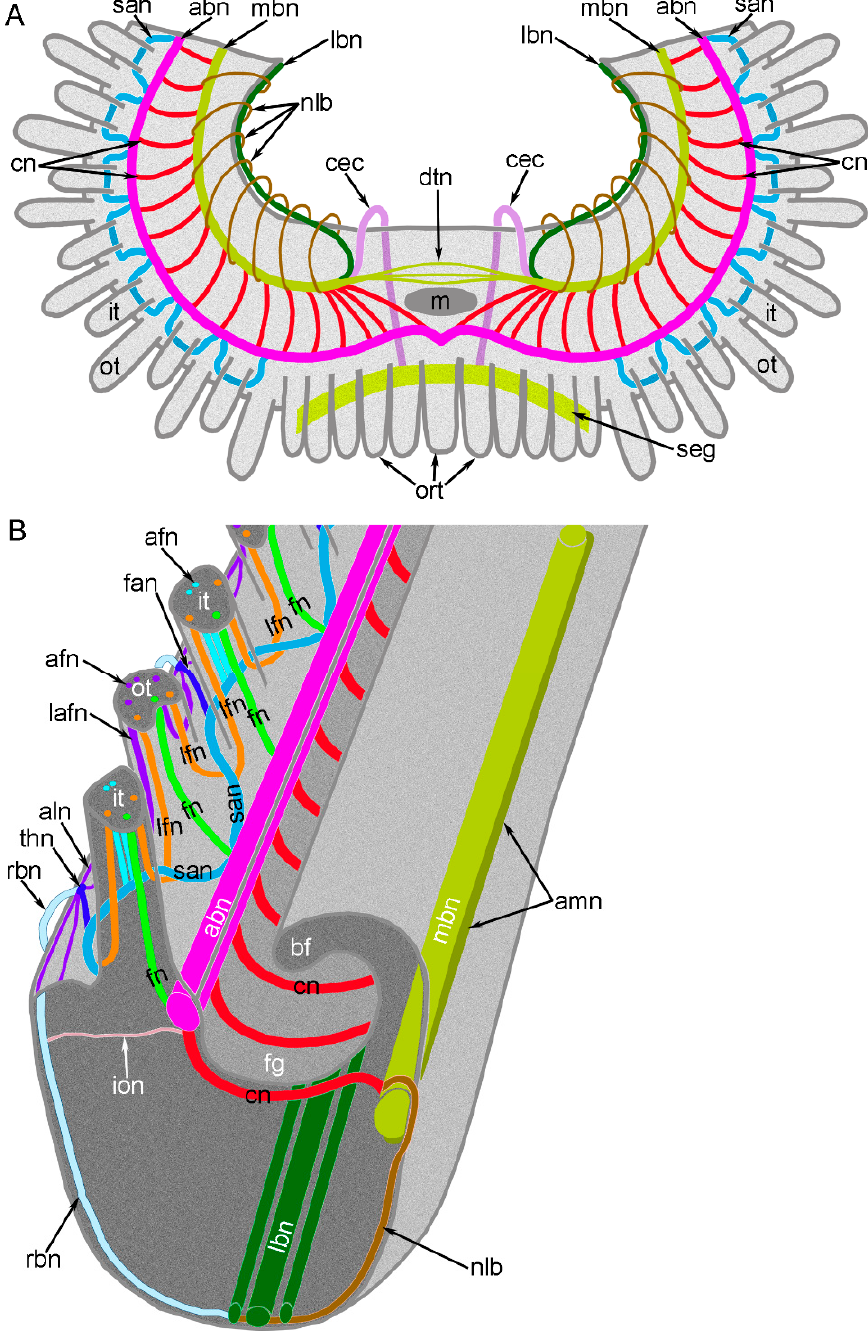
Figure 5. Schemes of innervation of the lophophore and tentacles in Novocrania anomala adults. ( A ) General scheme of the lophophore nerve elements. ( B ) A portion of the brachial arm with